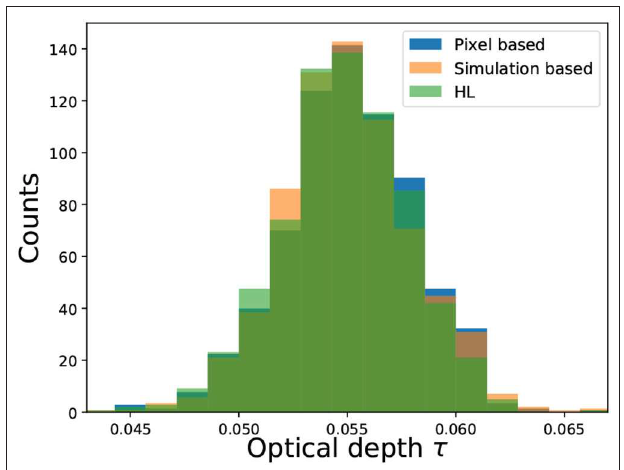
FIGURE 5 | Histograms of the recovered values of τ for the three likelihoods considered: pixel based (blue), simulation based (orange), and Hamimeche-Lewis